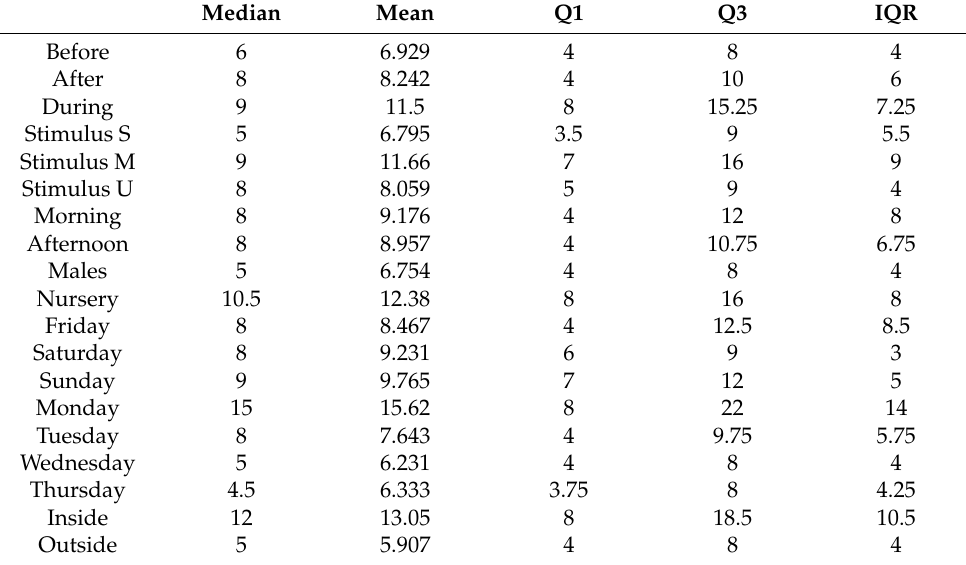
Table 3. Descriptive statistics, mean, median, Q1 (first quartile), Q3 (third quartile), IQR (interquartile range) of number of alarm reactions shown by deer as a reaction to the key variables. Alarm reactions before, after and during exposure to tourists, on Friday, Saturday, Sunday, Monday, Tuesday, Wednesday and Thursday, in the morning and in the afternoon, by males and nursery group, to the different stimuli, and to the stimuli presented inside or